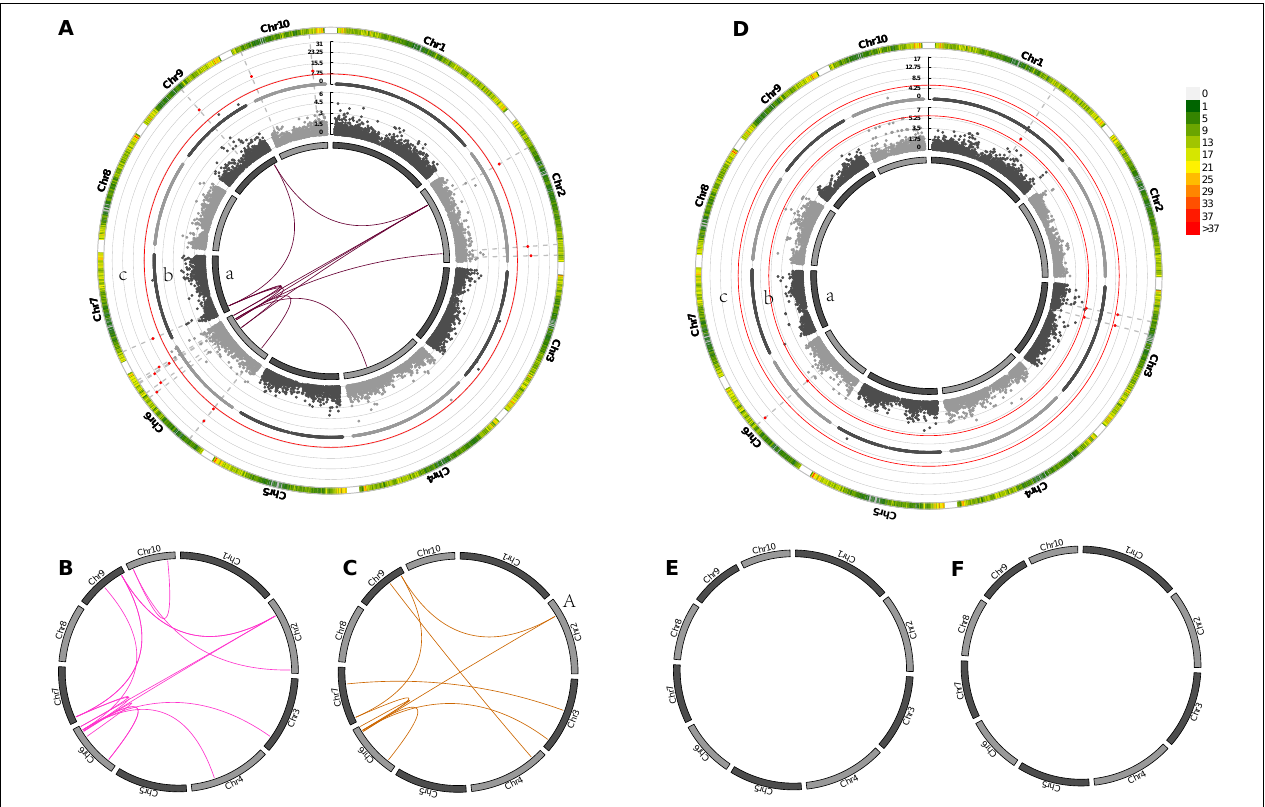
FIGURE 5 | Genetic effects of mid-parent heterosis for maize GWPP in temperate by tropical (A–C) and temperate by temperate (D–F) hybrids. (A–F) In the inner circle, 10 chromosomes are indicated by bars. Gray lines indicate the genetic map locations of SNPs. Color links within the circle indicate significant digenic epistatic interactions, including additive-by-additive [ (A) a, (D) a], additive-by-dominance (B,E) , and dominance-by-dominance (C,F) interactions. Manhattan plots for the heterotic effects [ (A) c, (D) c] and the dominance effects [ (A) b, (D) b] from genome wide association mapping are presented using Manhattan plots from GWAS. Red lines indicate the threshold of significance. Bar colors denote marker density, with one bar representing a window size of 1